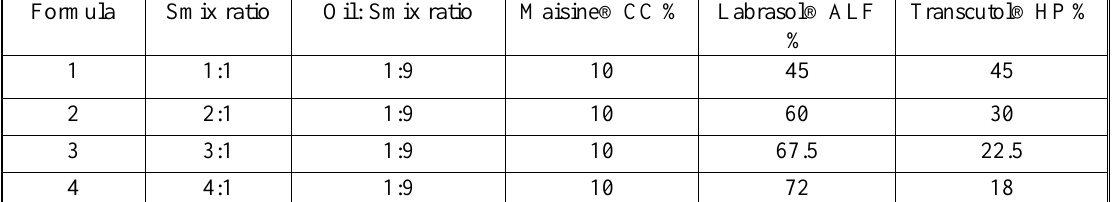
Table 1. Composition of tacrolimus liquid self-microemulsifying drug delivery systems (%w/w)